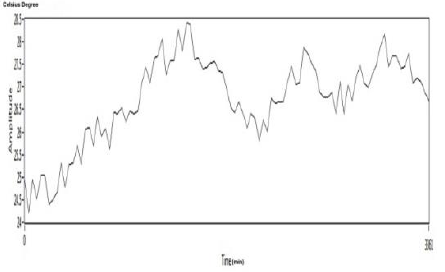
Figure 16. Temperature data stored by wireless sensor network monitoring system and LM35 analog sensor.